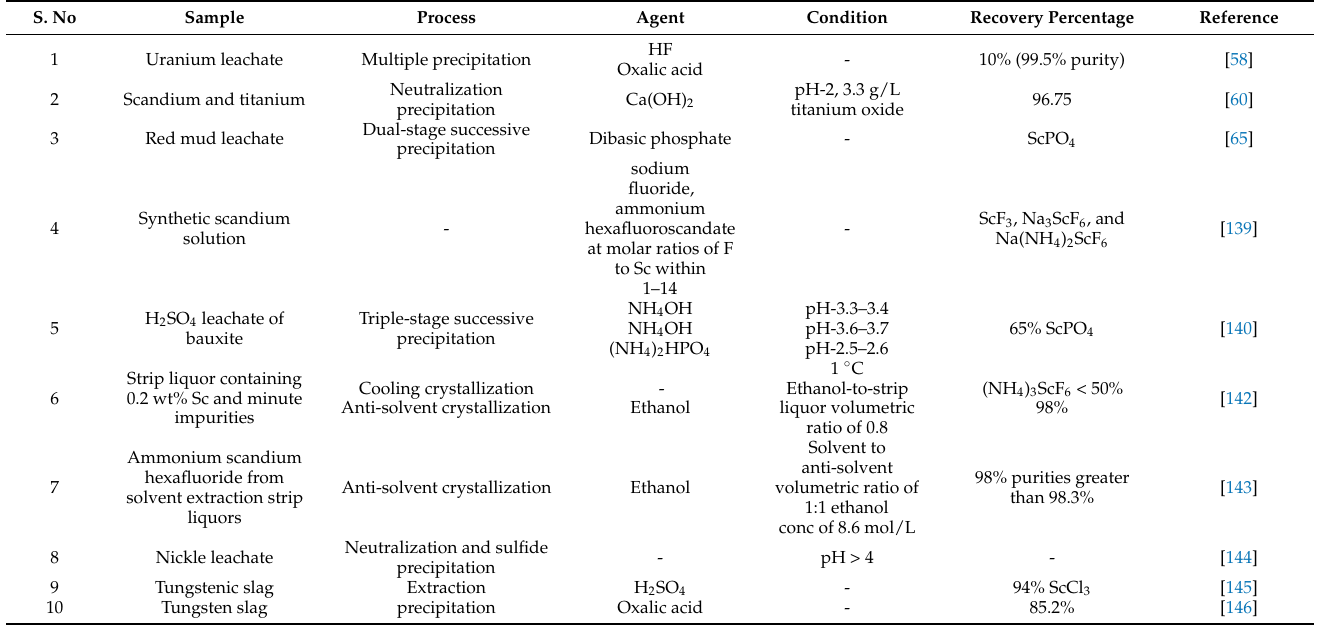
Table 7. Summary of precipitation and crystallization